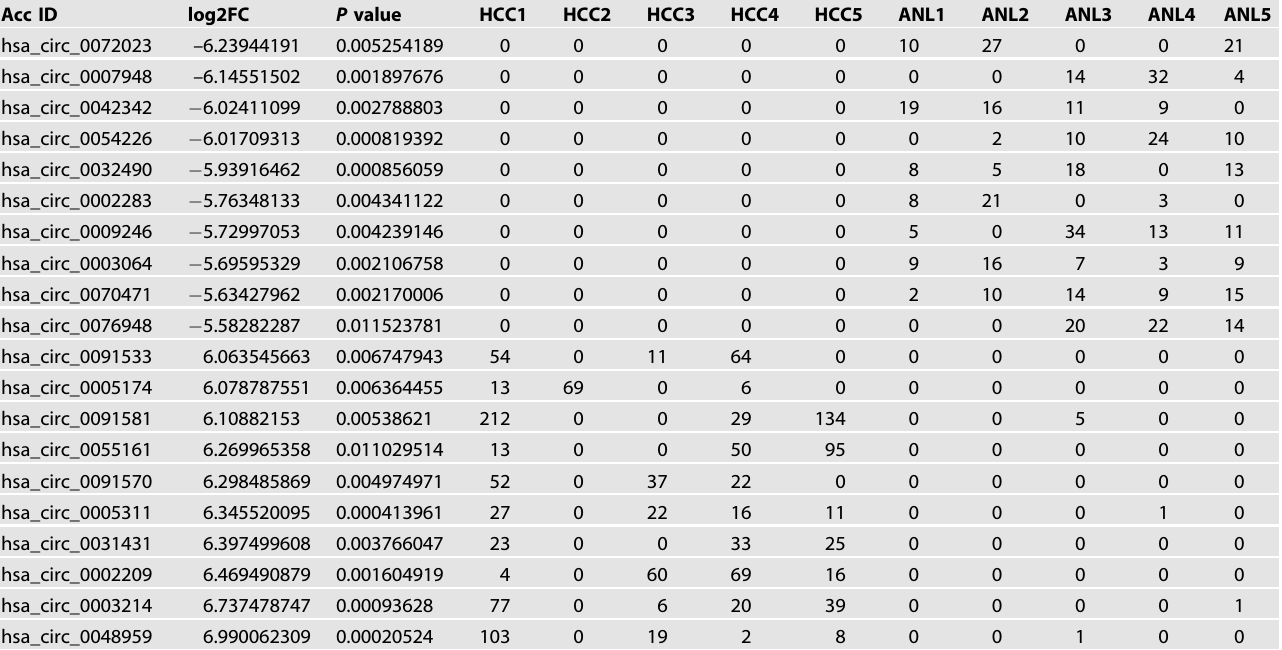
Table 1. top 20 up-regulated or down-regulated circRNAs in fi ve pairs of HCC